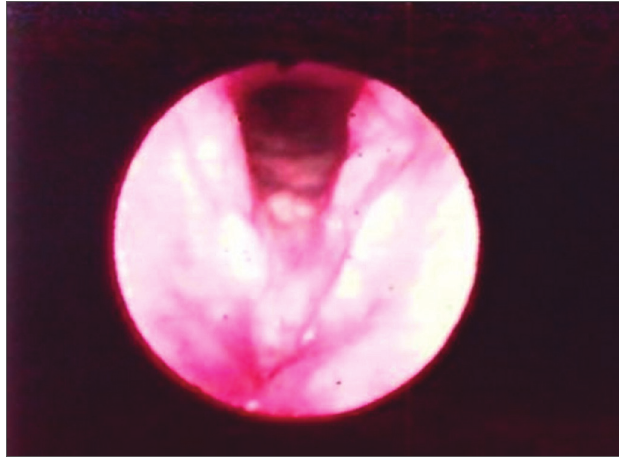
Figura 1. Hiperemia com espessamento de pregas vocais.